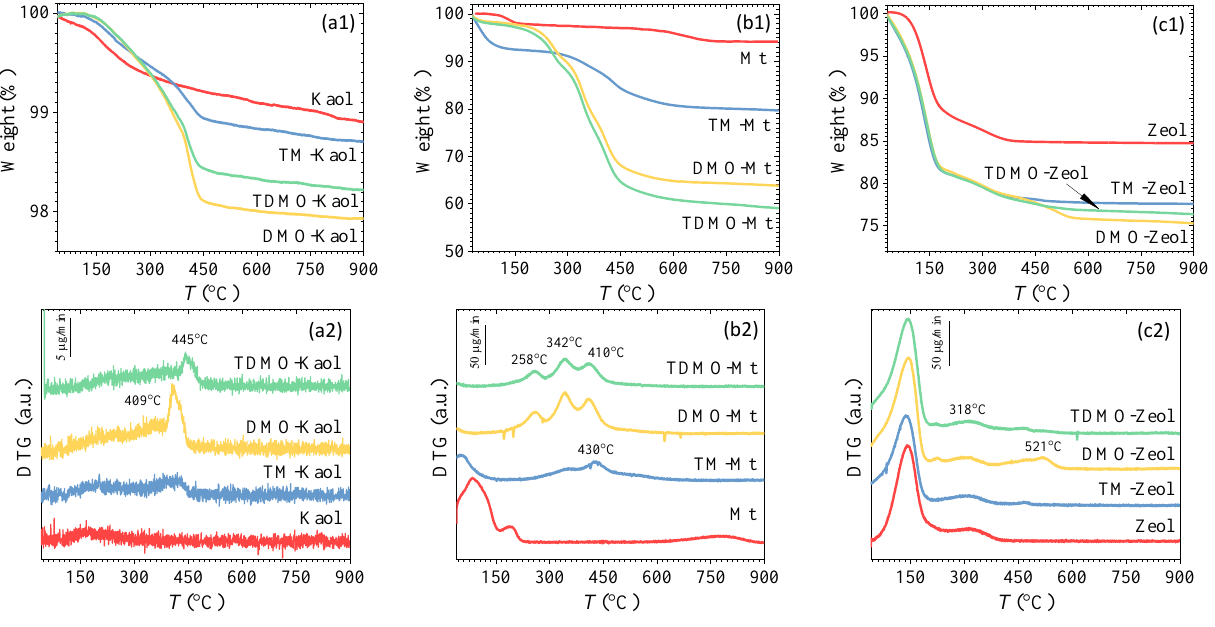
Figure 3. TG-DTG curves of the grafted ( a1 , a2 ) Kaol, ( b1 , b2 ) Mt, and ( c1 , c2 )